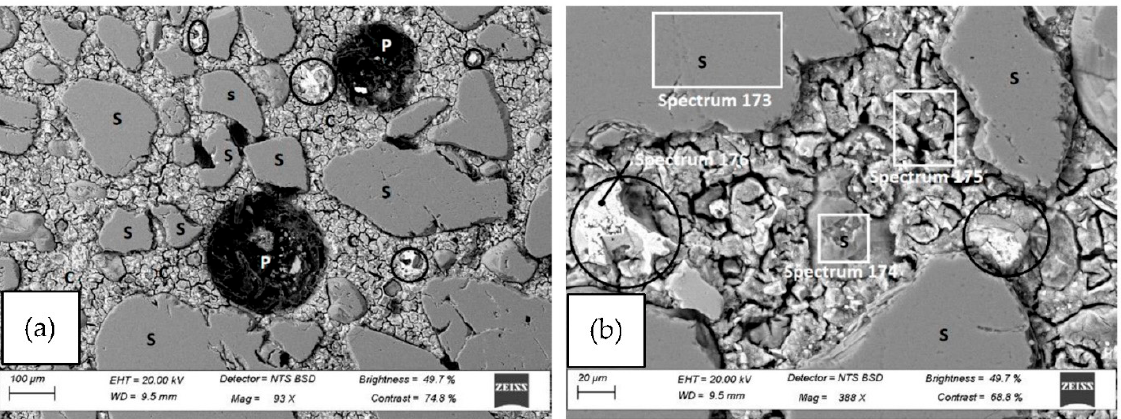
Figure 8. ( a ) SEM image showing the different particles in the OPC cement matrix where ‘S’ is sand, ‘P’ is a pore, ‘C’ is cement paste, and black circles showing unhydrated cement grains, ( b ) white blocks indicating the spectrums analysed with SEM-EDS.